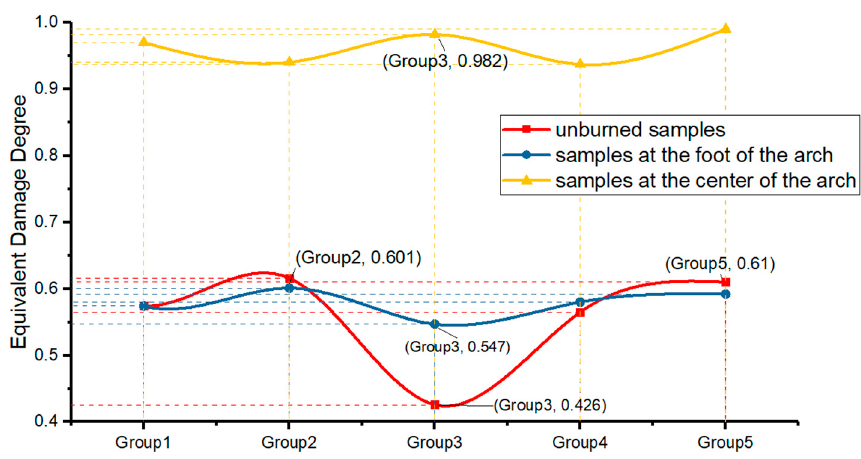
Figure 22. The 40 KG impact test for different parts of concrete lining structure.